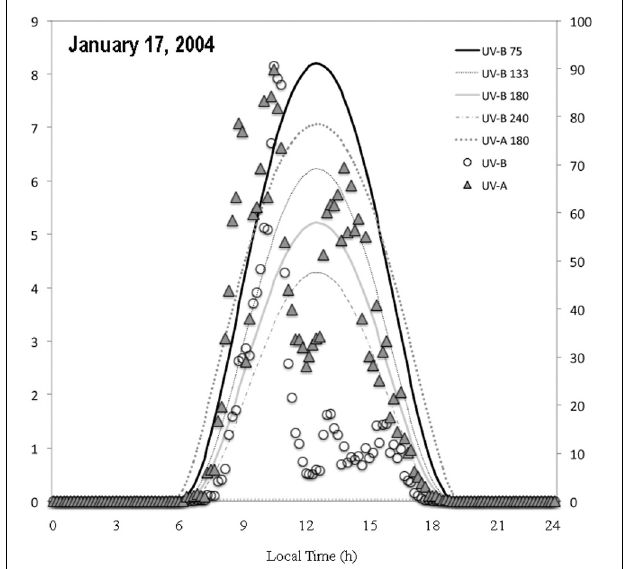
FIGURE 3 | UV irradiance at Licancabur. Measured UV-A and UV-B on January 17, 2004 at Licancabur compared to results of clear-sky model calculations using LibRadtran with column ozone of 75DU, 133DU, 180DU, and 240DU